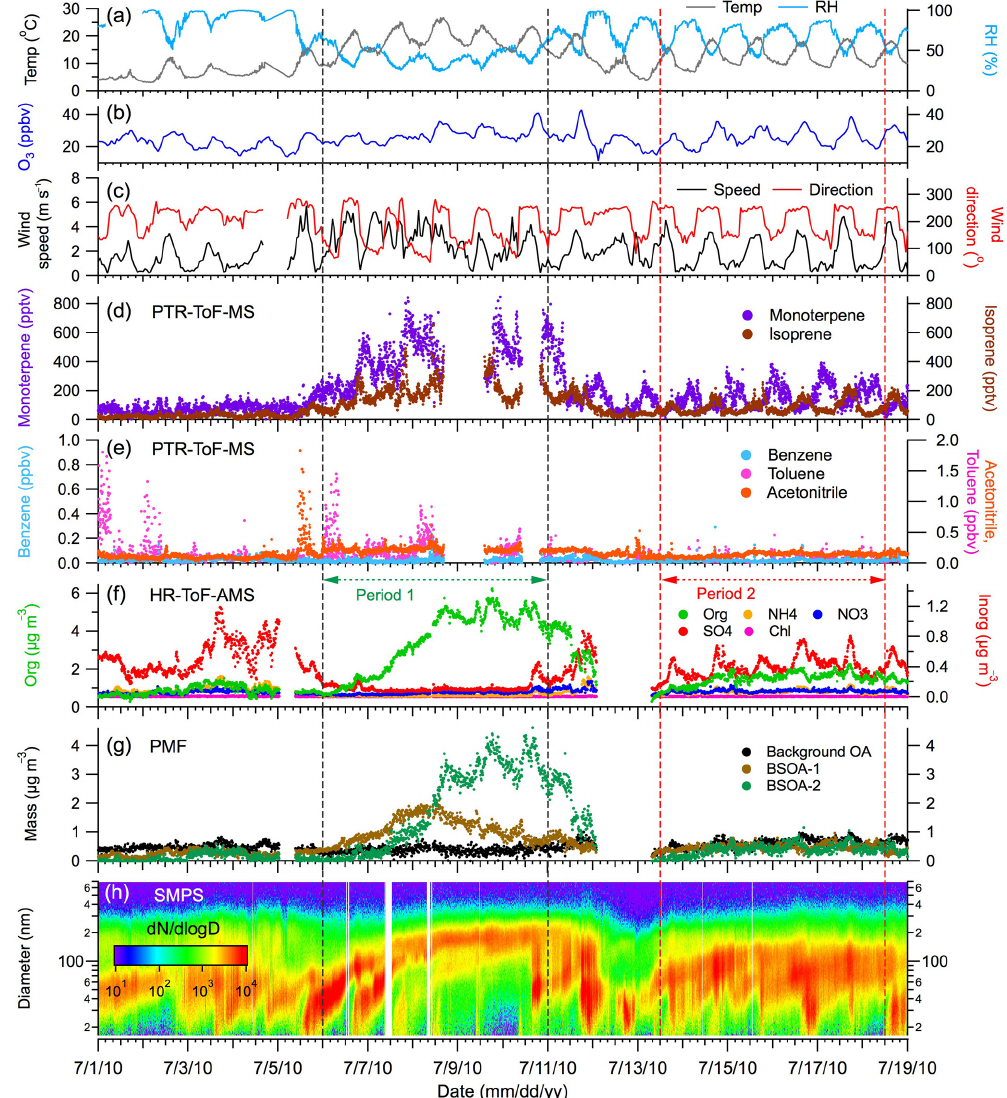
Figure 1. Time series (PST) profiles of (a) temperature and relative humidity, (b) ozone, (c) wind speed and direction, (d) monoterpene and isoprene measured by PTR-ToF-MS, (e) benzene toluene and acetonitrile measured by PTR-ToF-MS, (f) organic, nitrate, sulfate, ammonium, and chloride measured by HR-ToF-AMS, (g) background OA, BSOA-1, and BSOA-2 determined by PMF analysis, (h) particle number size distribution measured SMPS. The gray and red dashed lines represent the boundaries of Period 1 (6–10 July) and Period 2 (13–18 July), respectively. Figure S2 enlarges the time series during (a) 6–10 July and (b) 13–18